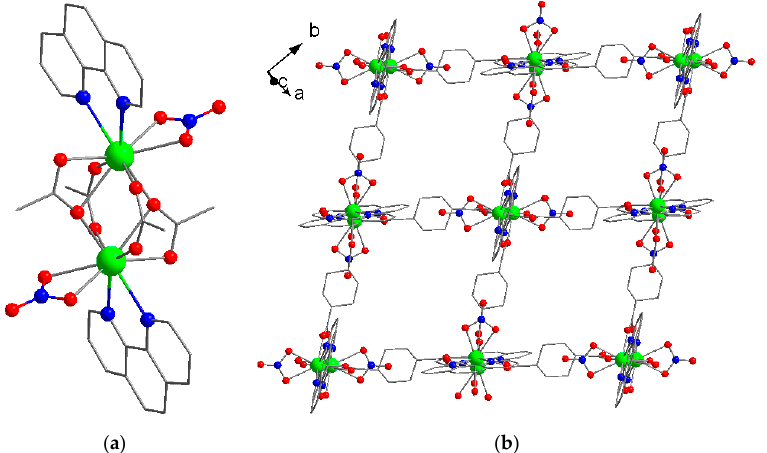
Figure 1. Binuclear block {Y 2 (phen) 2 (ONO 2 ‐κ 2 ) 2 ( μ‐ RCOO ‐κ 1 , κ 1 ) 2 ( μ‐ RCOO ‐κ 1 , κ 2 ) 2 } in 1 ( a ). Coordination layer in 1 ( b ). Y atoms—green, O atoms—red, N atoms—blue. H atoms and quest molecules are not shown.